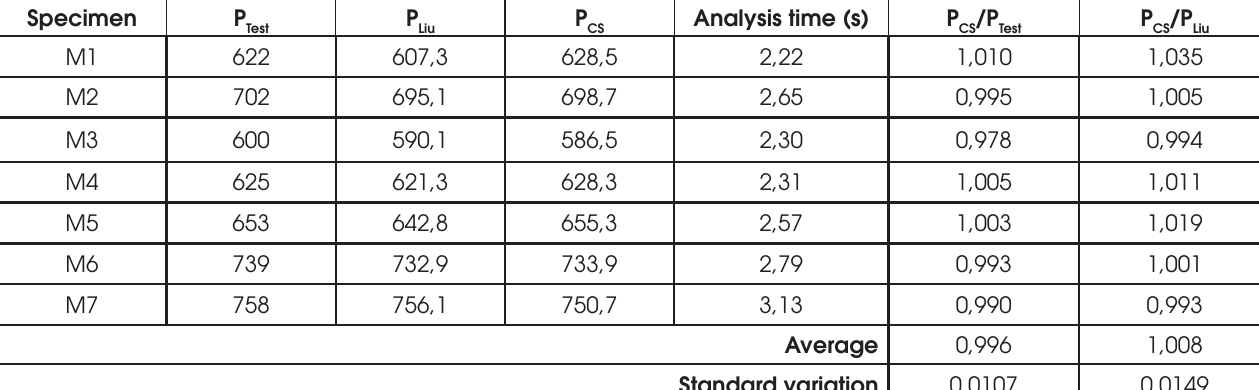
Critical loads (kN), obtained using SCM and comparisons with the literature results Specimen